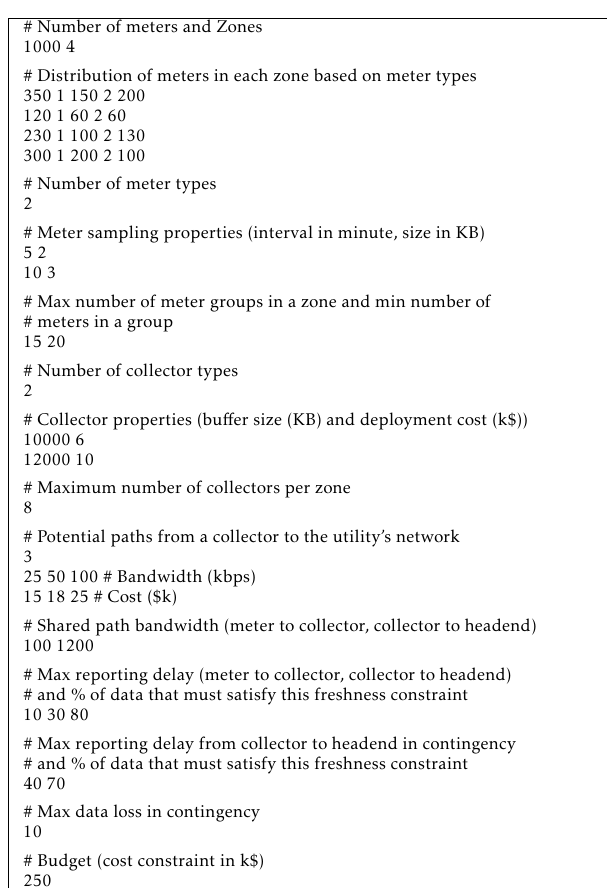
Table 3. Input to the Example